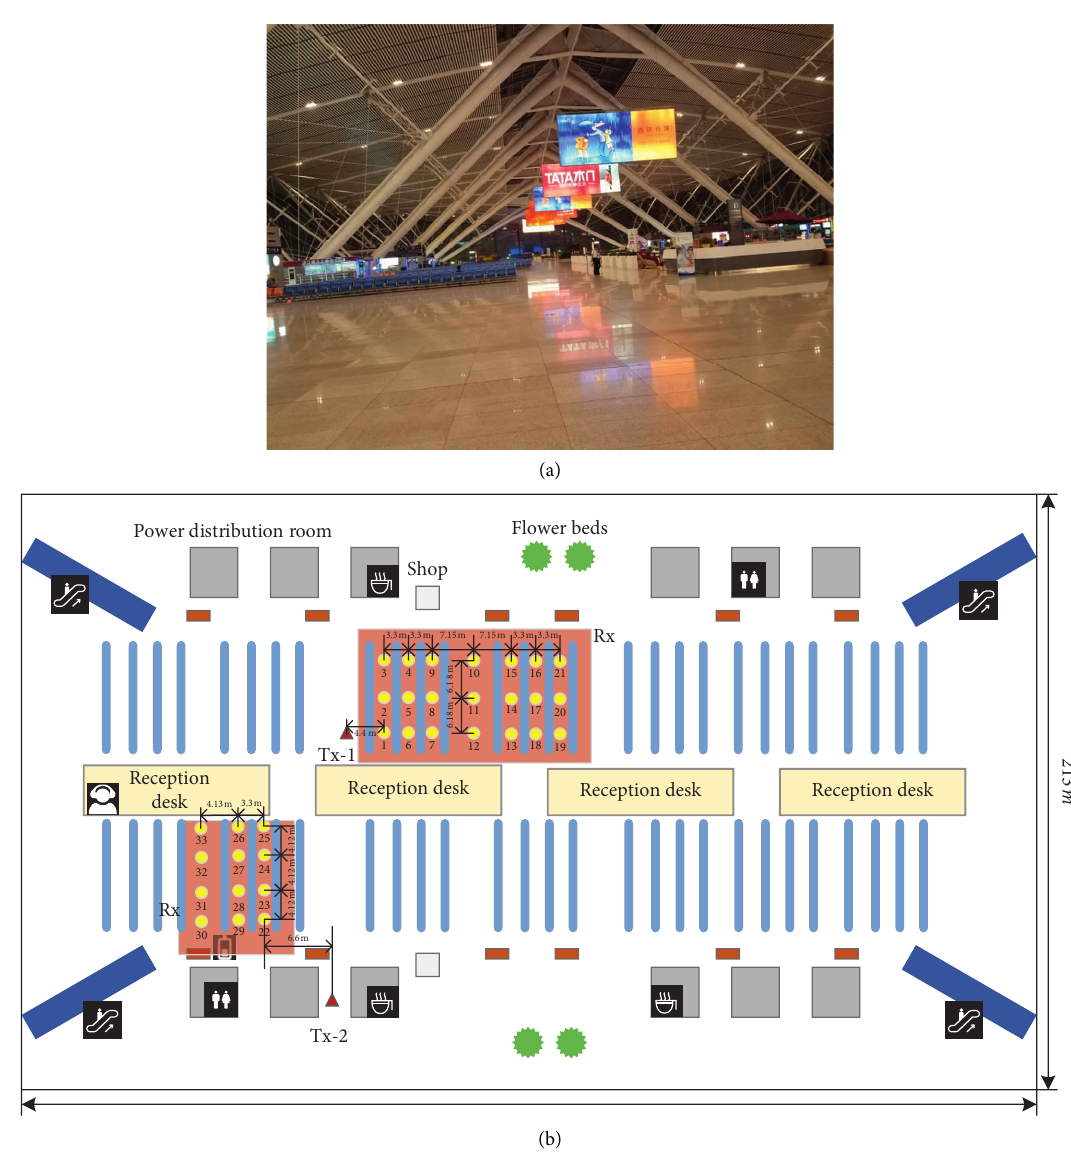
Figure 1: Measurement environment. (a) Top view of the measurement environment, (b) the position of Tx and the position of